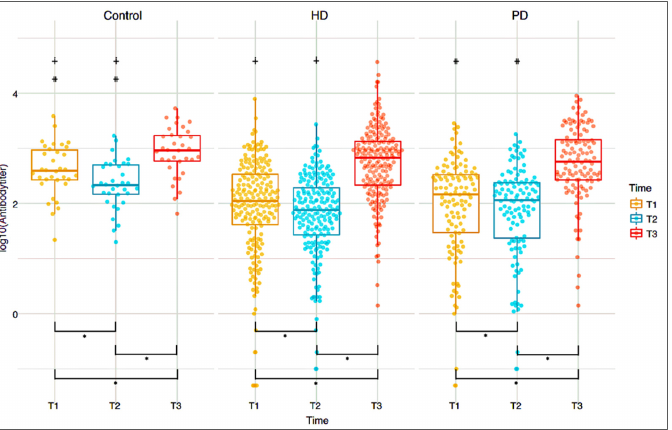
Figure 3. SARS-CoV-2 RBD IgG antibody titer values by group and time (T1 vs. T2 vs. T3). ∔ HD vs. Control ( p -value < 0.05), ⧺ PD vs. Control ( p -value < 0.05), * p -value < 0.05. 3.3. Adverse Events after AZD1222 Vaccination among Dialysis Patients and Controls Both the local and systemic AE were more severe after the first dose of the AZD1222 vaccine when compared with the second dose. HD patients were less likely to experience local and systemic AE compared with PD patients and controls. Pain, tenderness, and a need for painkiller use were local AE with significant differences between groups, while fatigue, fever, headache, muscle/joint pain, abdominal pain, and anorexia/vomiting were systemic AE with significant differences (Figure 4).